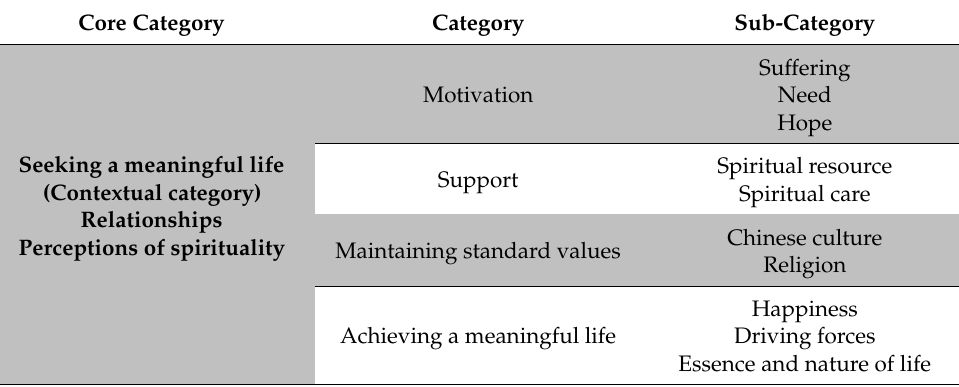
Table 2. Core category, categories and